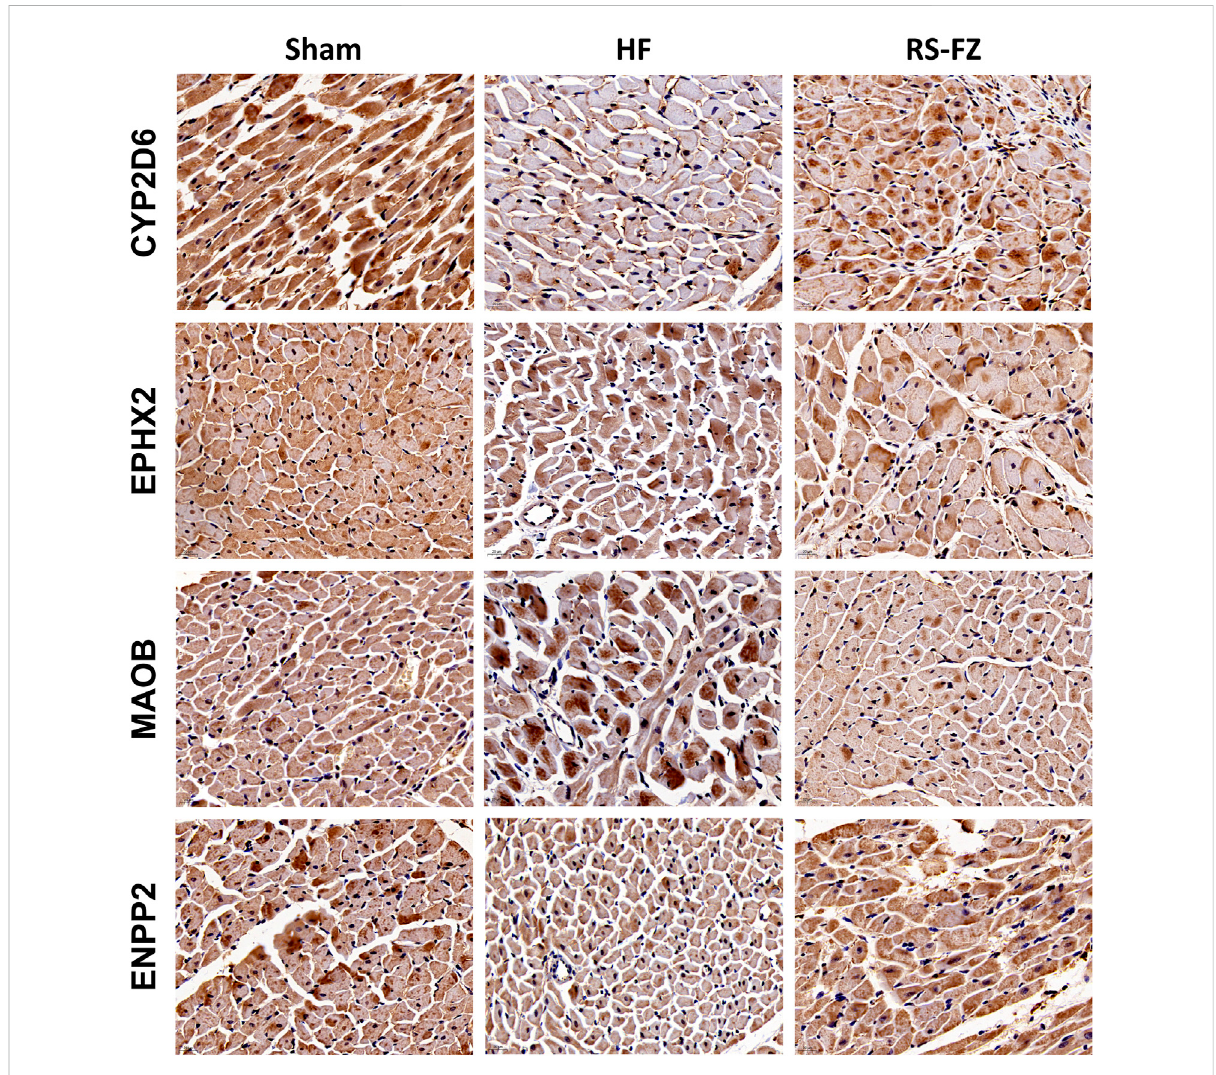
FIGURE 7 Effect of RS-FZ on the expression of the critical targets in the treatment of HF detected by immunohistochemistry staining (×400). The vital targets detected in heart tissue are CYP2D6, EPHX2, MAOB, and ENPP2.